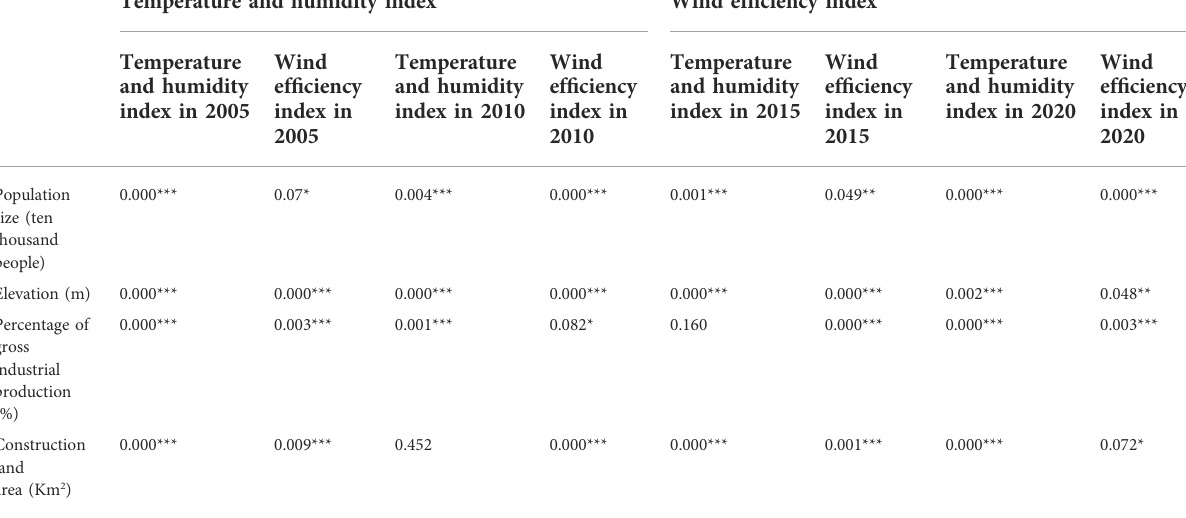
TABLE 3 Correlation of factors affecting climate comfort of human-settlement in 2005, 2010, 2015, and